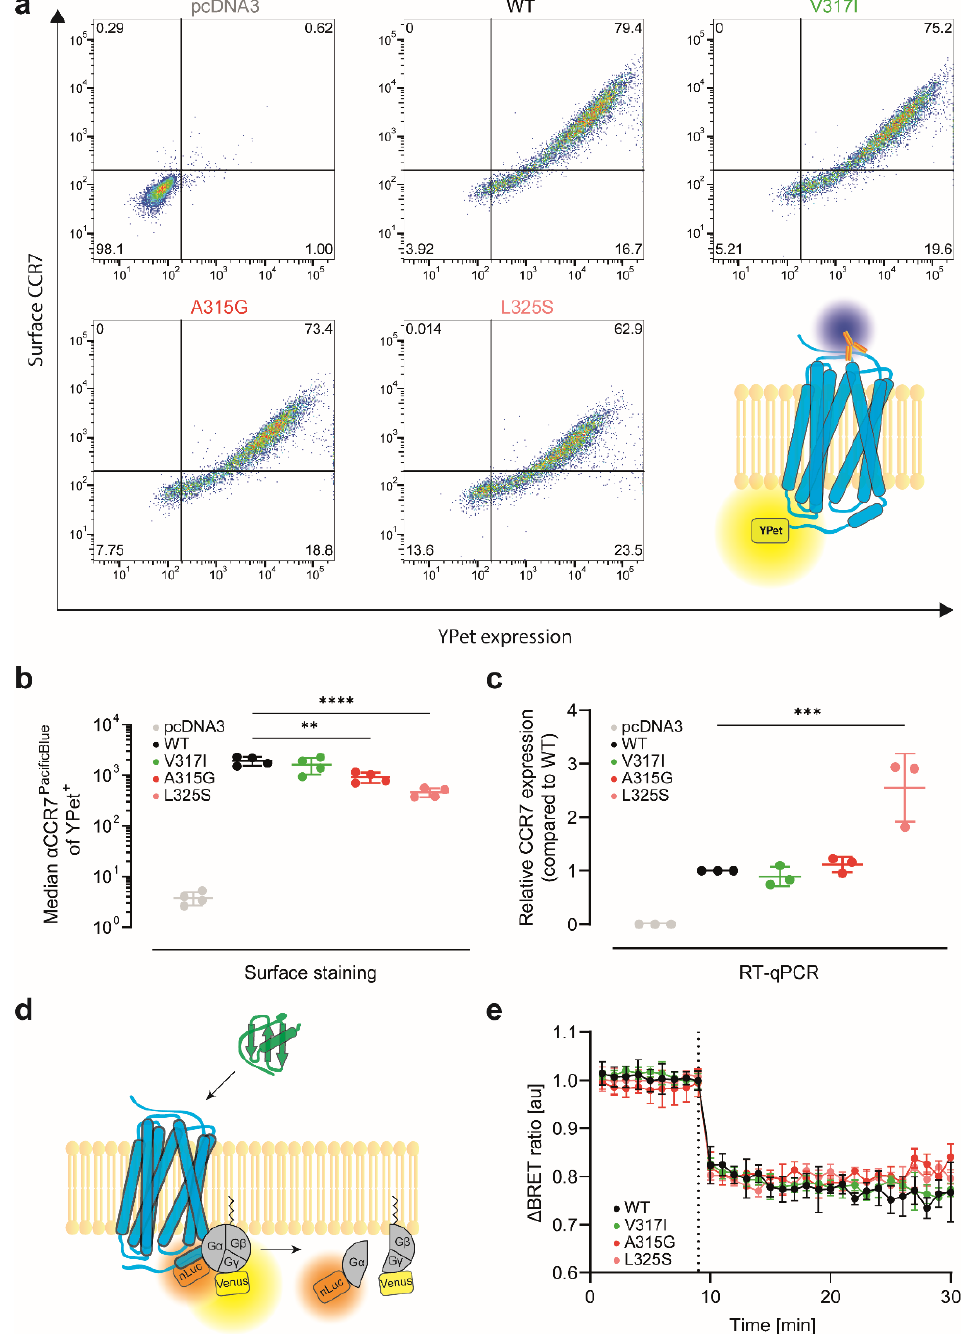
Figure 2. CCR7 and its dimerisation mutants are expressed at the cell surface and elicit CCL19-induced G i -protein activation: ( a ) total and surface expression of CCR7 variants. HeLa cells were transiently transfected with CCR7 variants fused to YPet. Transfection with empty vector (pcDNA3) served as negative control. Total protein expression (YPet) and surface expression (antibody stain- ing) were determined by flow cytometry. One representative out of 4 independent experiments is shown; ( b ) quantification of the median CCR7 surface expression of the 4 independent experiments in ( a ) are shown; ( c ) mRNA expression of the transiently transfected CCR7 variants shown in ( a , b ) was quantified by RT-qPCR; ( d ) schematic representation of the G i -protein activation assay. Chem- okine-induced dissociation of the G α i -subunit from the G βγ -subunits of the heterotrimeric G-pro- tein was measured by a loss of BRET signal; ( e ) G i -protein activation by CCR7 variants upon stim- ulation with 1 μ M CCL19 (dotted line). n = 3, mean ± SD. ** p < 0.01; *** p < 0.001; **** p < 0.0001.